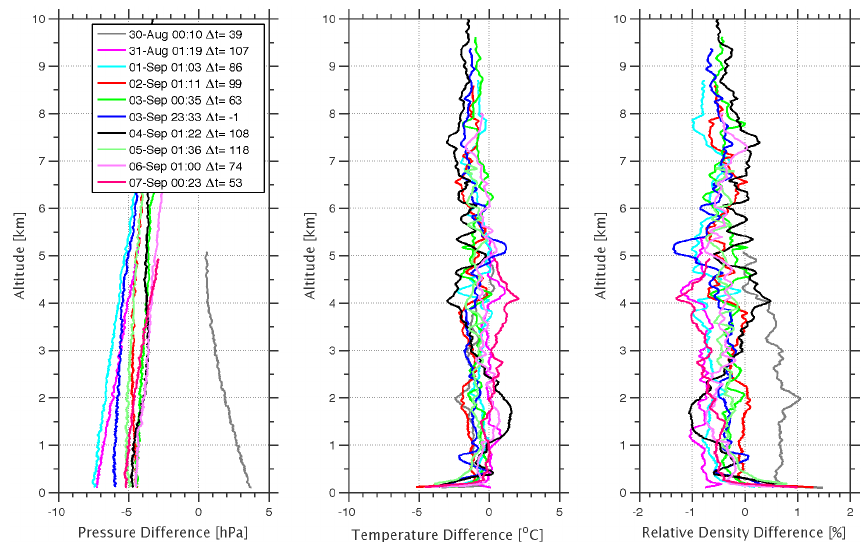
Figure 4. Pressure (hPa, left), temperature ( ◦ C, center) and relative air density (%, right) differences between the Embrapa’s and operational’s radiosondes are shown. Dates in the legend correspond to the launching time at the lidar site.